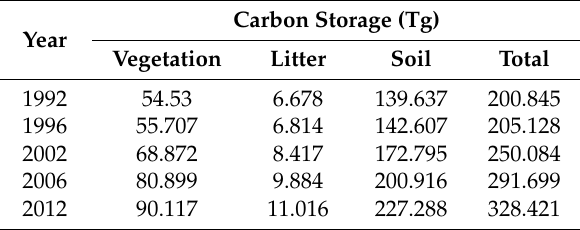
Table 6. Carbon storage of the Forest Ecosystem in TGR area from 1992 to